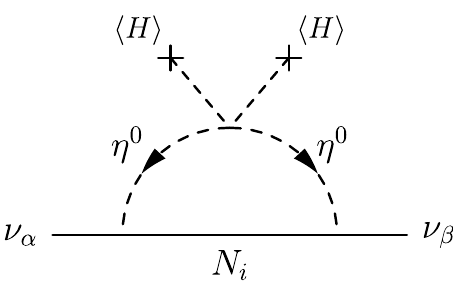
Figure 1 . Diagram for Majorana neutrino masses at one-loop